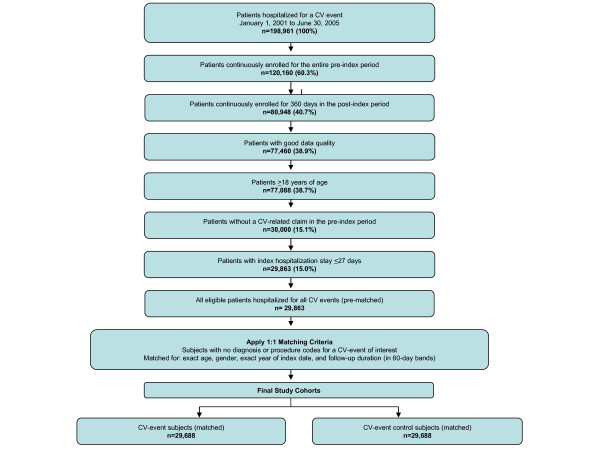
Diagram of study cohort identification procedure.